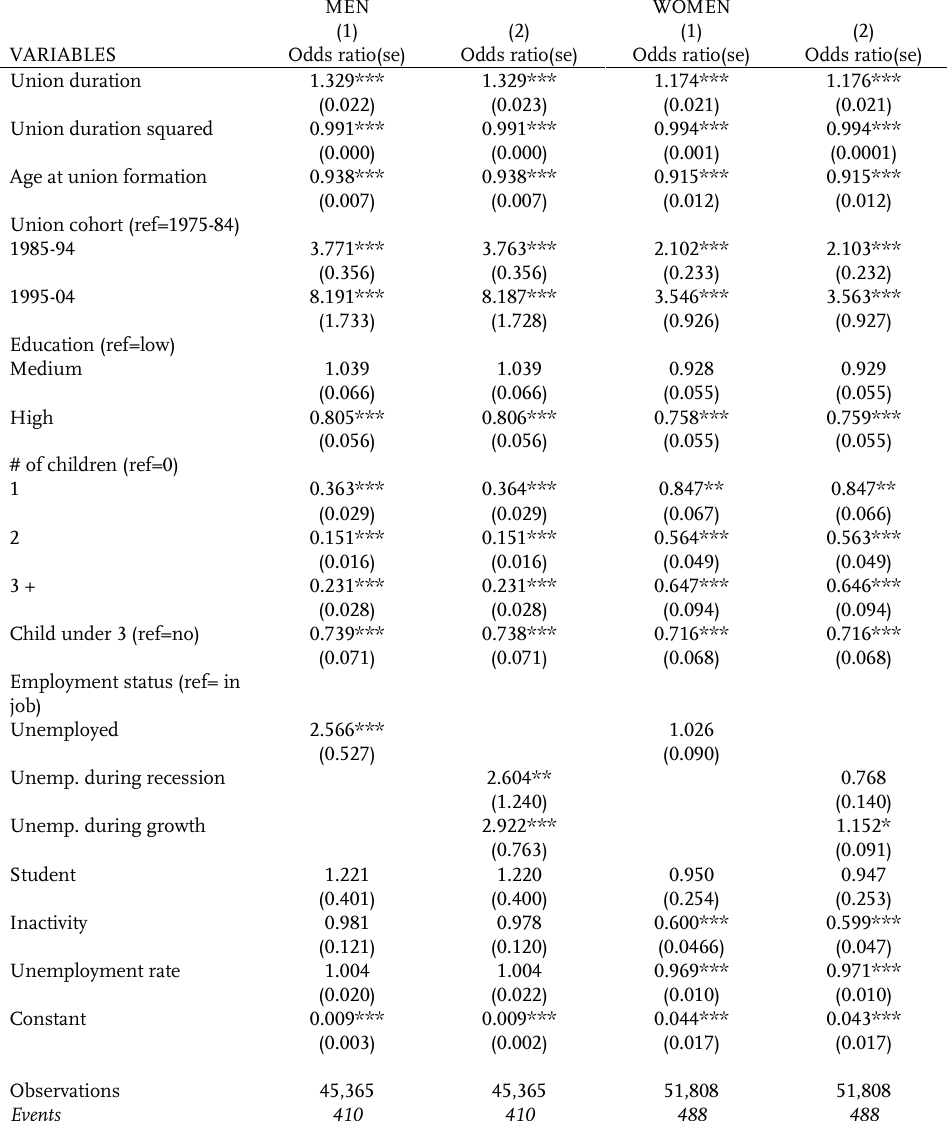
Table A.1 : Discrete time model, full results by country: Belgium